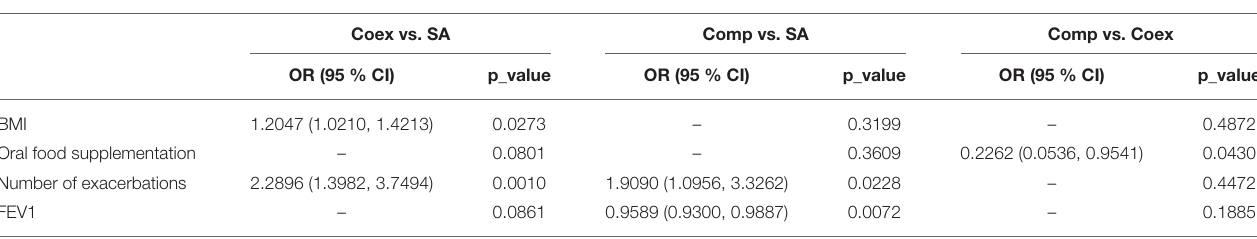
TABLE 4 | Adjusted odds ratios of cystic fibrosis patients’ infection status.